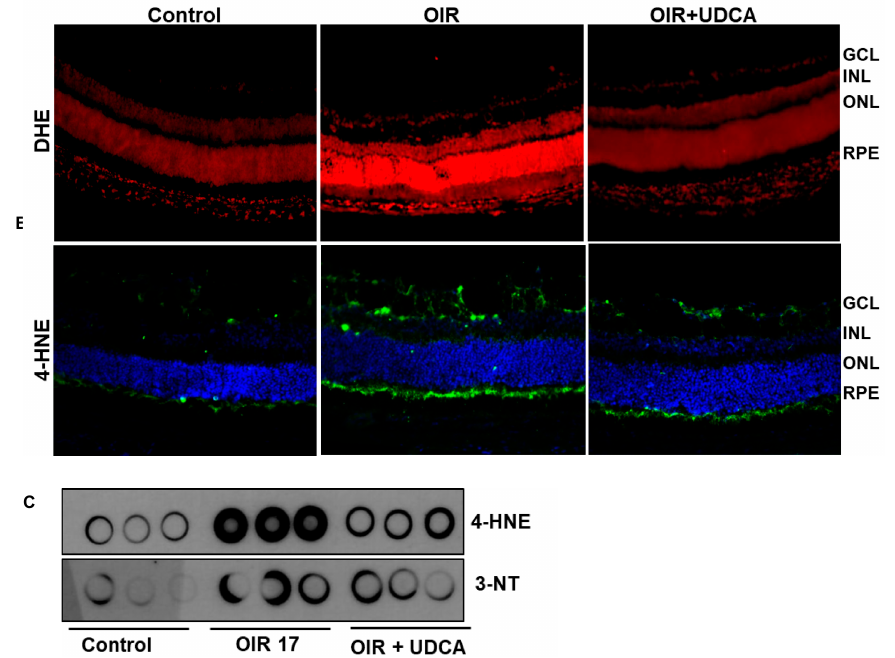
Figure 6. Effect of UDCA treatment on oxidative stress in OIR mice. Frozen retinal sections from control mice at P17 (room air), OIR mice, and OIR mice treated with 50 mg/kg UDCA (P7–P17) were stained with ( A ) dihydroethedium (DHE) and ( B ) 4-hydroxynonenal (4-HNE) to assess oxidative stress. ( C ) Dot blot assay assessing 4-HNE and 3-nitrotyrosine (3-NT) levels from total protein fractions extracted from control mice (room air), OIR mice at P17, and OIR mice treated with 50 mg/kg UDCA (P7–P17).